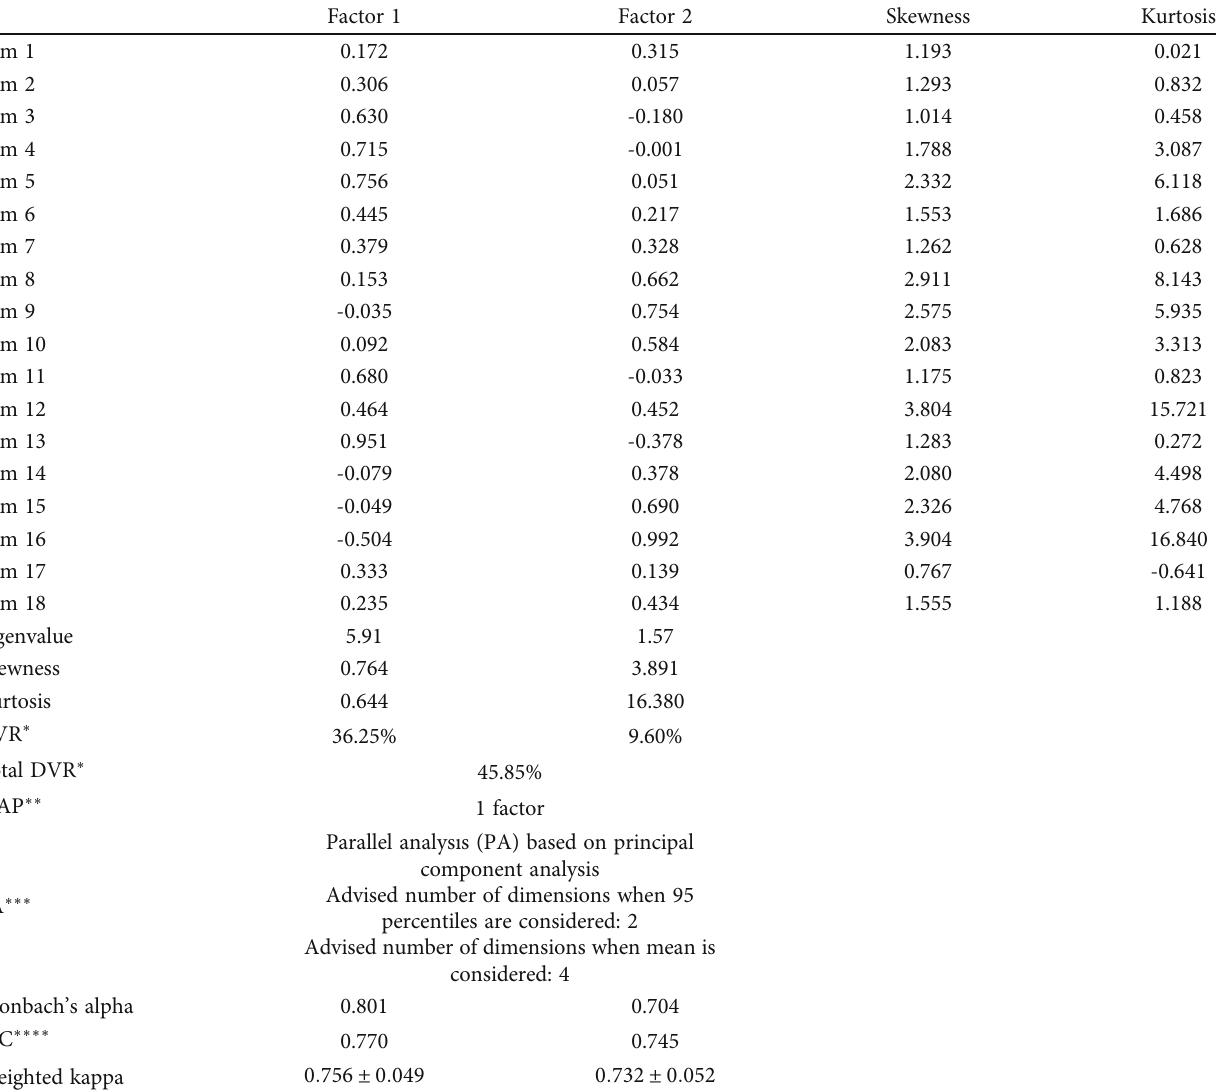
Table 3: Factor loads of two-factor structure obtained by MRFA and factor subtraction